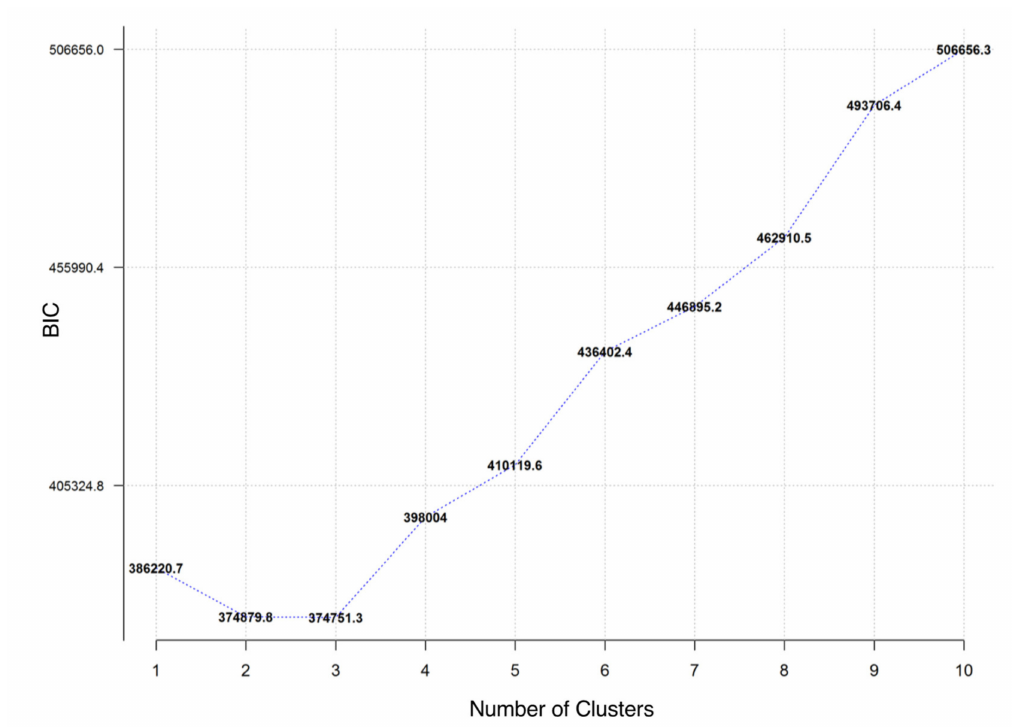
Figure 1. K-means optimal cluster determination. The lowest Bayesian Information Criterion (BIC) indicates the best fit model and thus the optimal number of clusters for k-means clustering